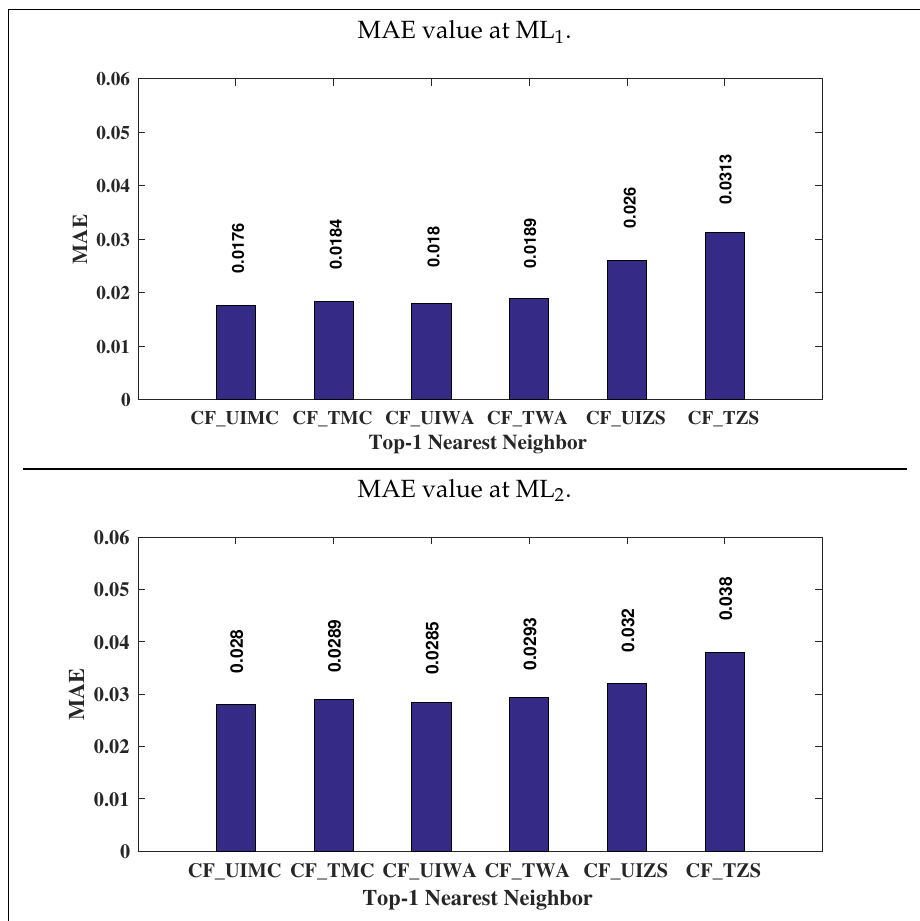
Figure 6. MAE Value at